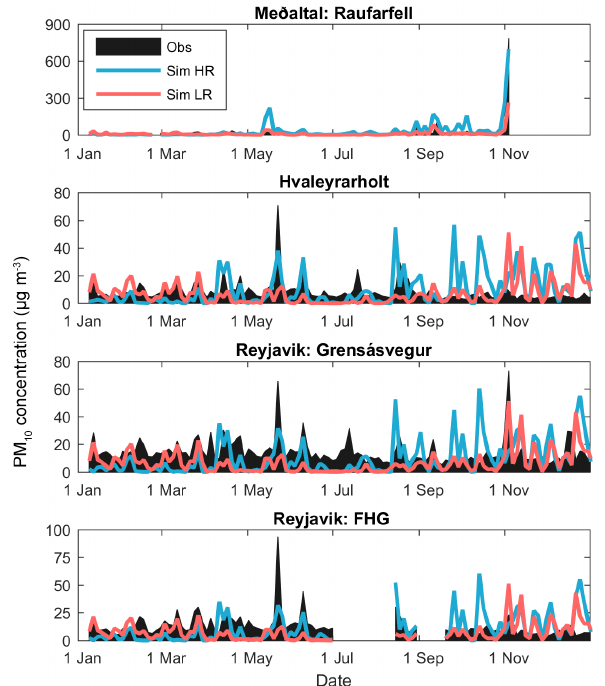
Figure 4. Weekly mean PM 10 concentrations in 2012 at four sta- tions as observed (black), modelled at high resolution (blue) with ECMWF analysis data (0.2 ◦ ) and modelled at low resolution (1.0 ◦ ) with ERA-Interim data (red).